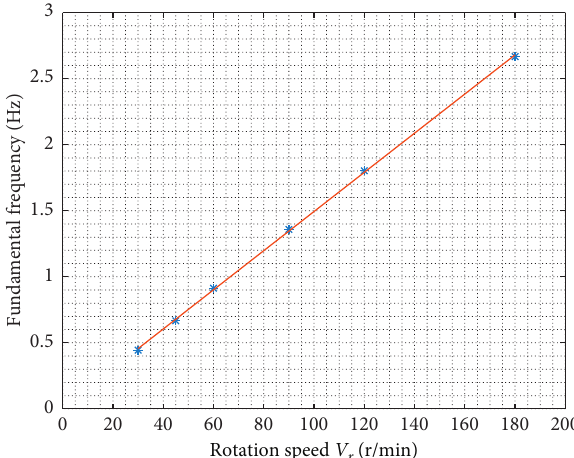
Figure 13: Variation of the fundamental frequency of torque under different rotation